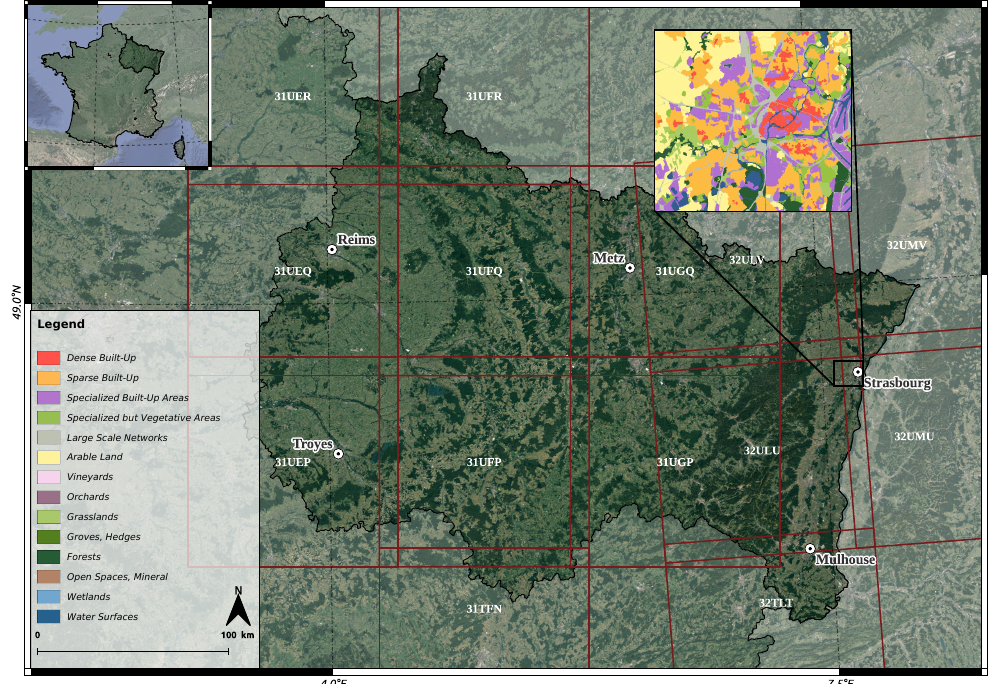
Figure 1. Grand-Est region with ground reference subset, Sentinel-2 tiling grid and major cities. Sentinel-1 carries a C-band SAR sensor and offers dual polarization data in Ground Range Detection (GRD) and Single Look Complex (SLC). Only GRD products are used in the construction of MultiSenGE and each Sentinel-1 patch consists of a stack of VV and VH